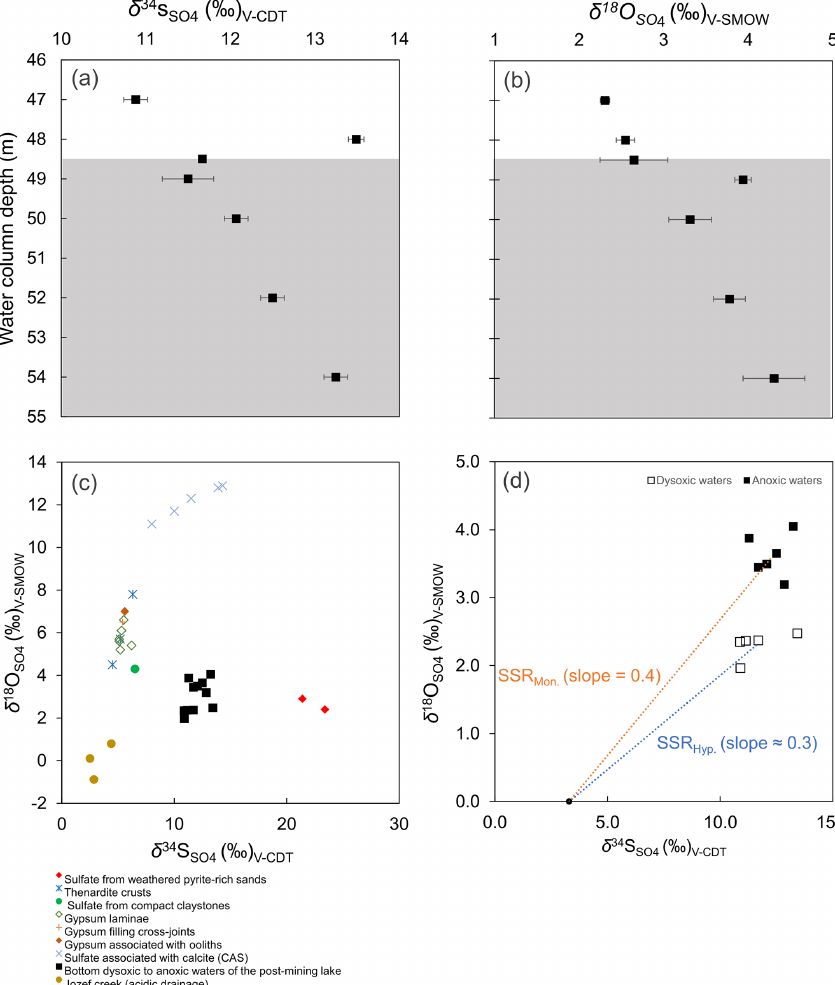
Figure 5. The bottom water column δ 18 O SO and δ 34 S SO values (a–b) . Grey background colour code as in Fig. 2. Also, a cross-plot of 4 4 these values in the water column vs. those of all possible sources of dissolved SO 2 − to the modern lacustrine system (c) . The coupled 4 sulfur and oxygen isotope-constrained slopes of the linear regressions provide a rough estimation of the sulfate reduction rate (SRR) (d) . The regressions considered the δ 18 O SO and δ 34 S SO of the acidic drainage to be the initial isotope composition of dissolved sulfate immediately 4 4 after flooding (see text for